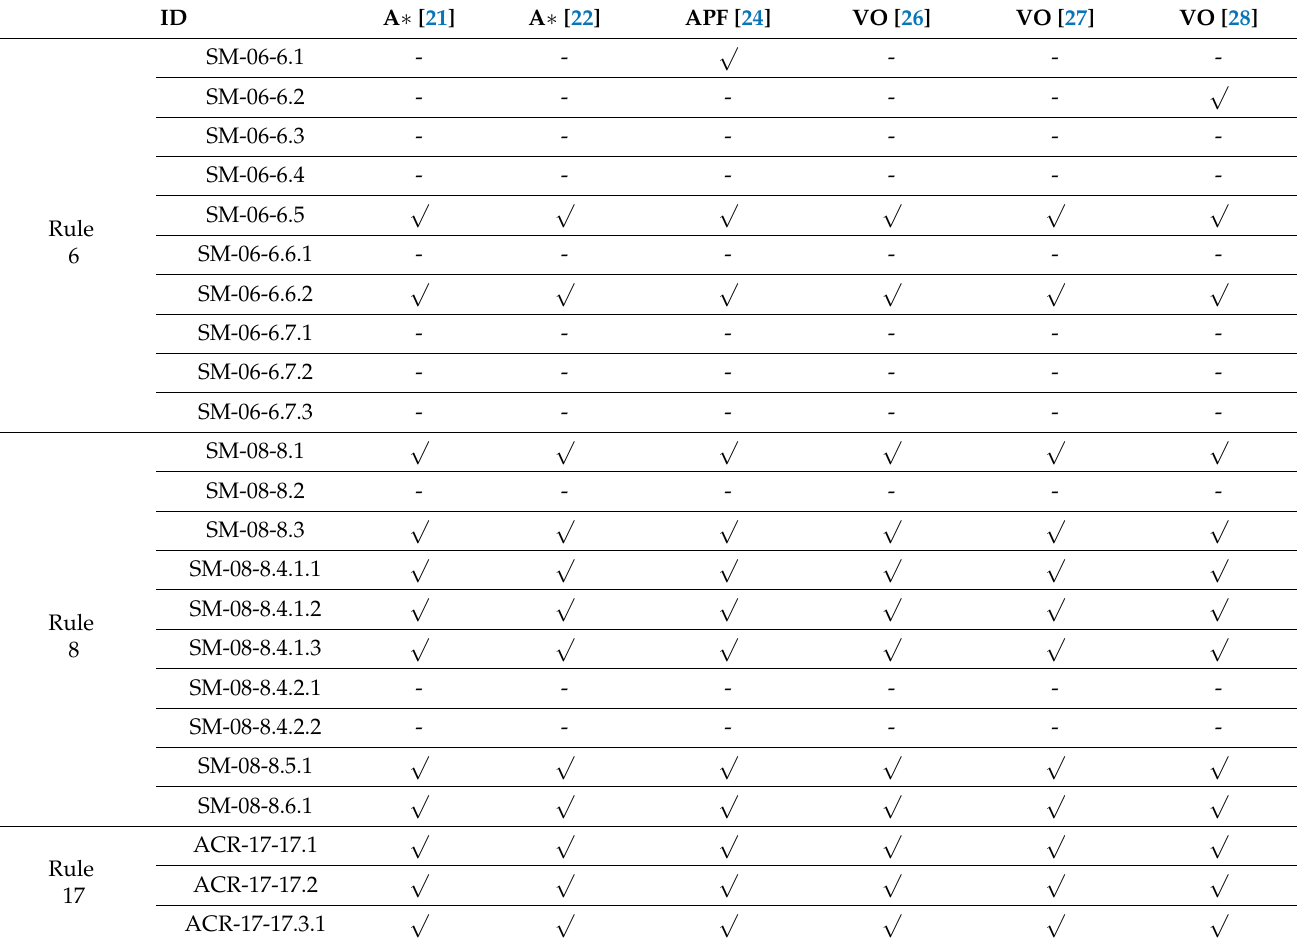
Table 14. Validation for requirements specifications for ship